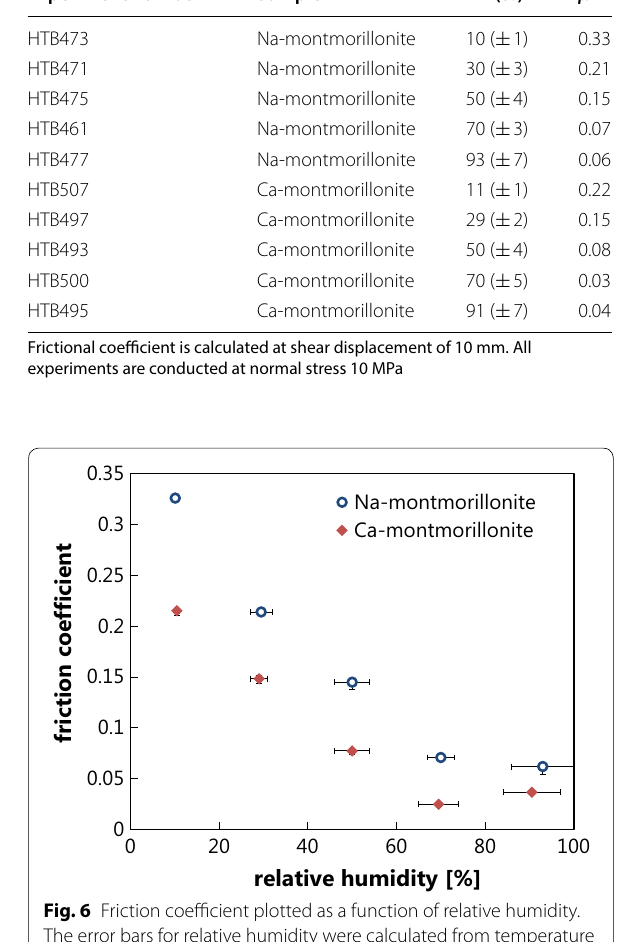
ferent values of relative humidity (RH)